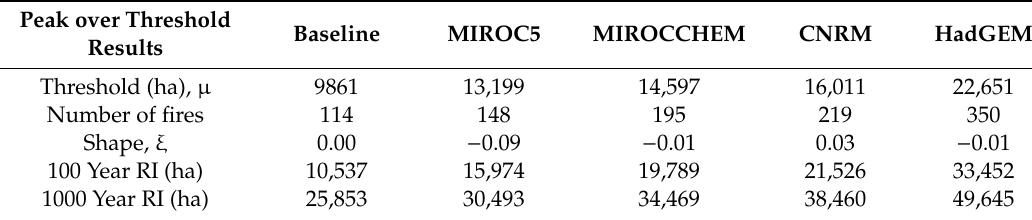
Table 3. Results from a generalized Pareto distribution (GPD) model of 99th percentile fire sizes under each climate scenario. The threshold of fire sizes for consideration was set at the 99th percentile of each scenario’s fire size distribution. Shape parameters close to 0 indicate that fire size distributions are light-tailed exponential and negative values indicate that fire sizes are finite. 100- and 1000-Year return intervals (RI) refer to the fire size (ha) with a 0.01 and 0.001 probability of